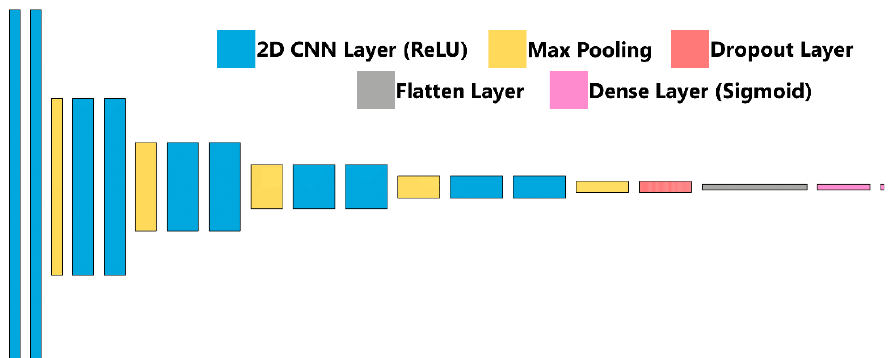
Figure 3. ShrapML Architecture. Block diagram for visualization of the neural network architecture for ShrapML used in training the shrapnel detection models.